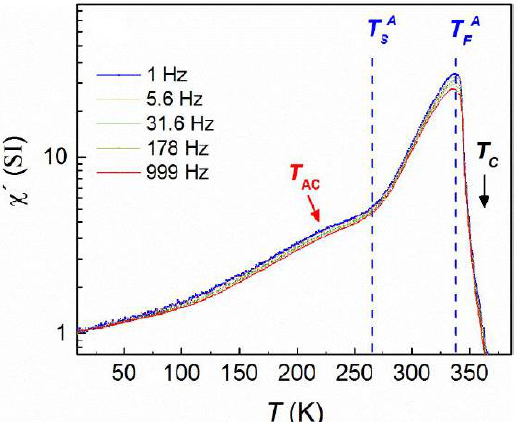
Figure 4. Log scale plot of the AC volume susceptibility after ZFC at zero DC bias field and different frequencies f . Units are SI.